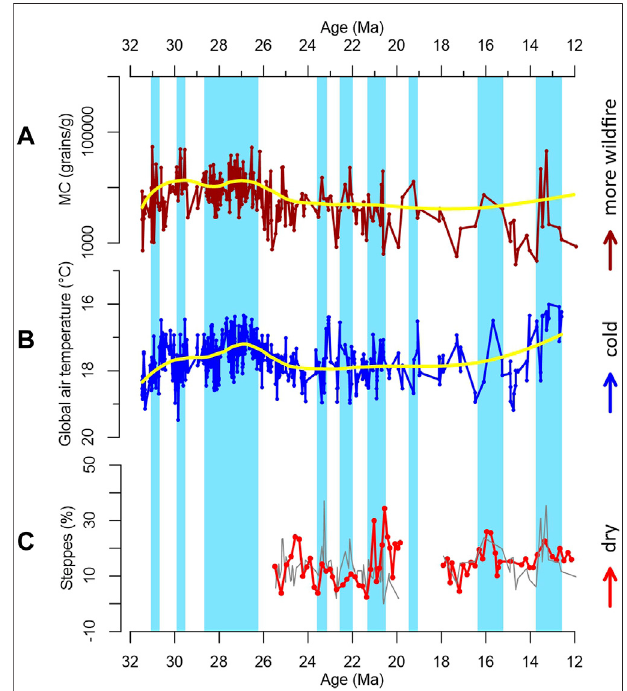
FIGURE4| Correlationsbetweenwild fi retoaridityandtemperature. (A) . MC records according to older age model. (B) . global temperature curve (Westerhold et al., 2020) chosen according to the MC old model. (C) . aridity records basing on steppes in pollen assemblages during ~26 – 20 Ma (Sun et al., 2014) and 18 – 5 Ma (Miao et al., 2011). Gray curve is a copy of the (A) to couple to these two intervals and sample frequency in Lunpola is three. The vertical light blue rectangles showed the positive correlations. Yellowish solid line shows the LOESS Fit with span: 0.5.